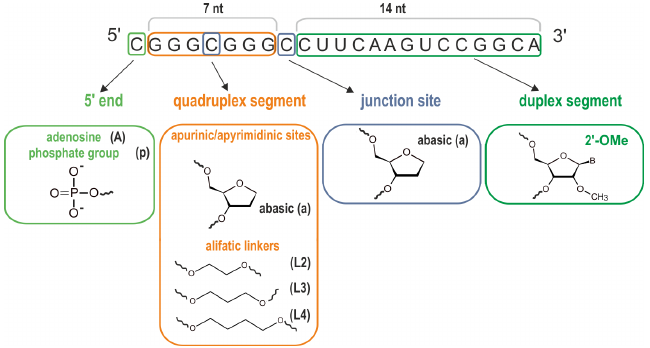
Figure 6. The chemical formulas and the sites of chemical modifications in the QD strand.